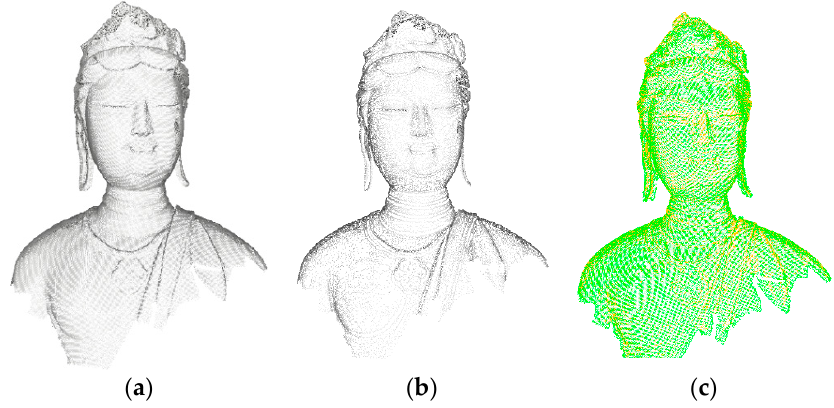
Figure 8. ( a ) Original points, ( b ) point clouds at one level, and ( c ) supplementing the missing points. Orange points are level points and green points are the supplemented points.